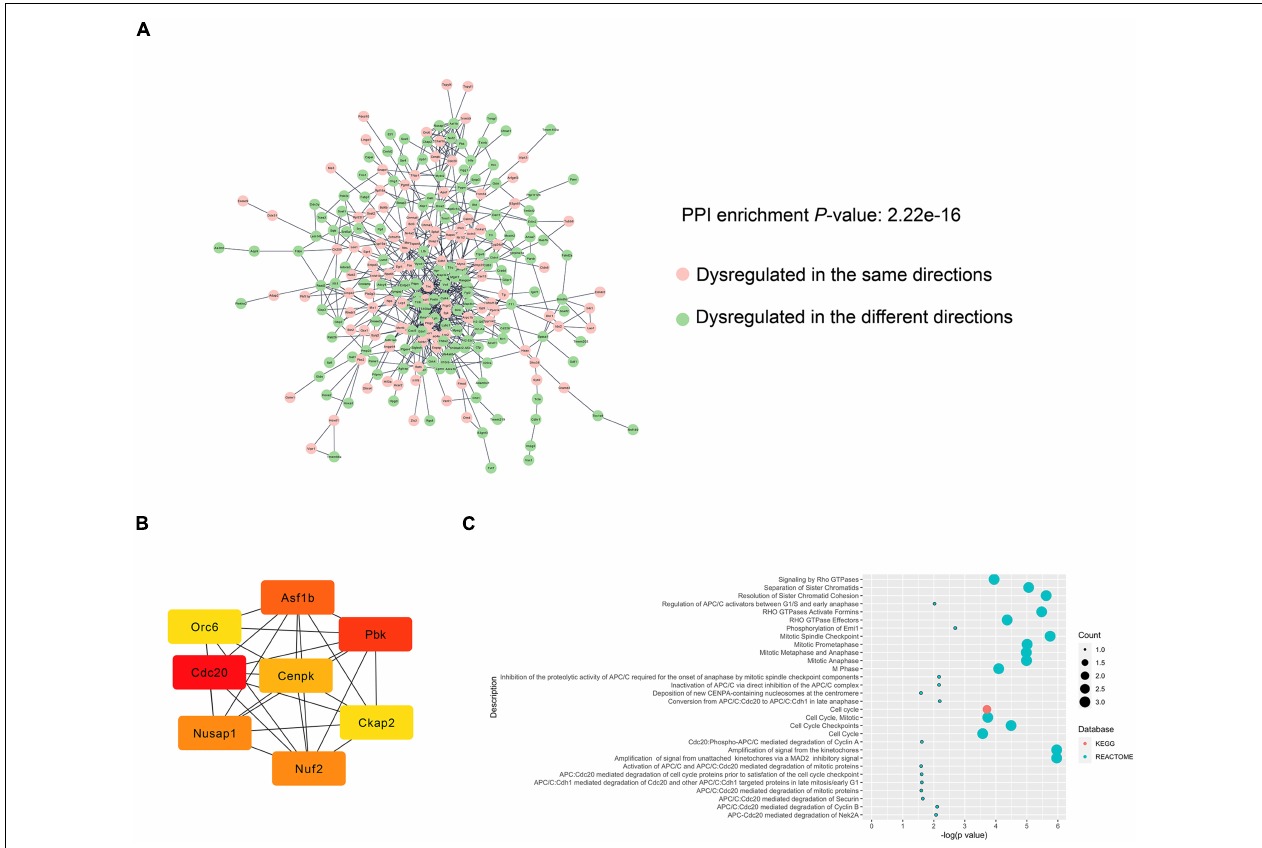
FIGURE 6 | PPI analysis of the DEGs between the POCD and AD hippocampus. (A) PIN reconstruction of the hippocampal DEGs between POCD and AD. Red, upregulated nodes; green, downregulated nodes. (B) The core cluster consists of eight genes with the color shading representing the score calculated by the maximal clique centrality algorithm. (C) Over-presentation analysis of the core